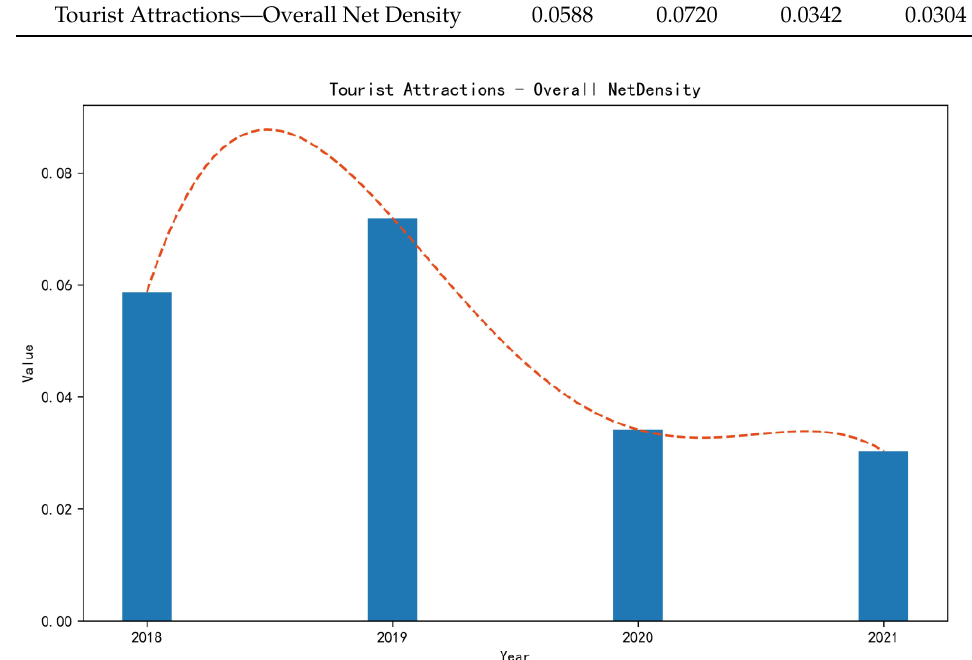
Table 2. Overall network density of tourism flows.